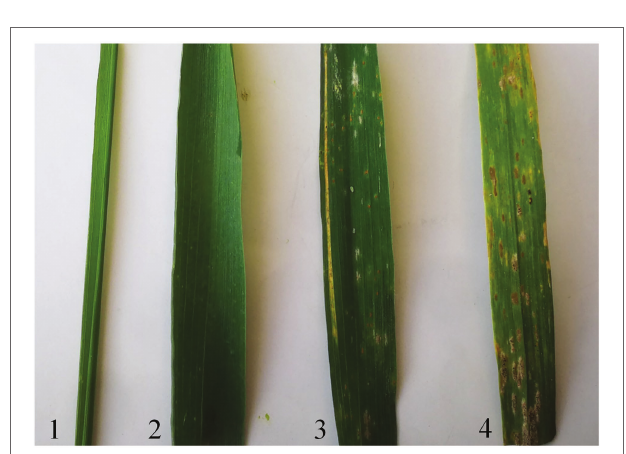
FIGURE 5 | Powdery mildew responses of P. huashanica , line E24-3-1-6-2- 1, line 7182, and Mingxian 169 (from 1 to 4) to a mixture of 30 powdery mildew ( Bgt ) isolates at the adult stage.